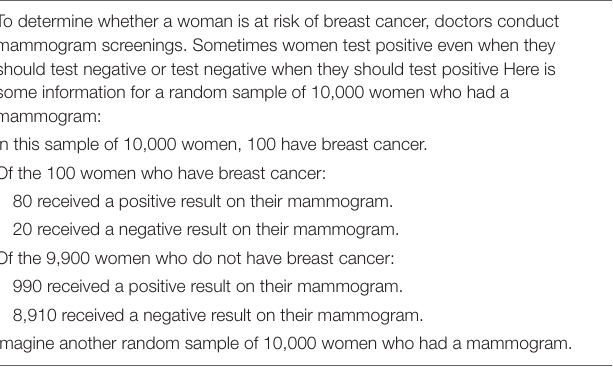
TABLE 4 | Example presentations with full subset information for the mammography problem. Incongruent condition-Focus problem – Full subset information